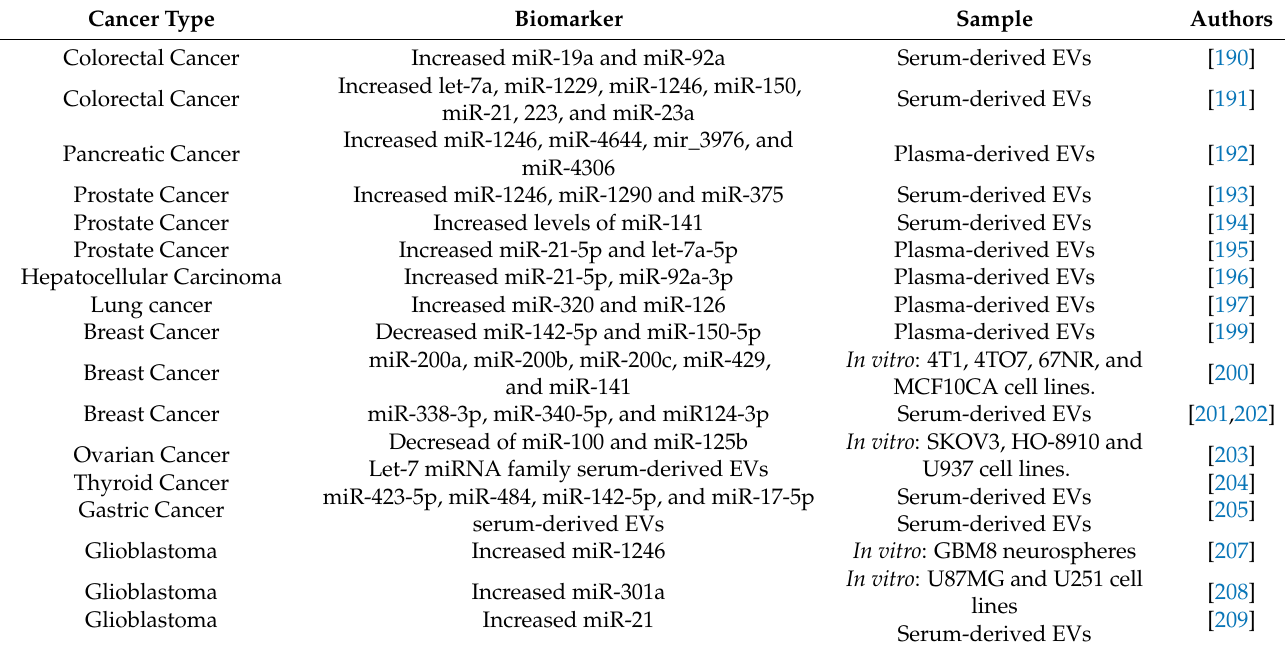
Table 3. Summary of the miRNAs identified in EVs with potential as biomarkers of different